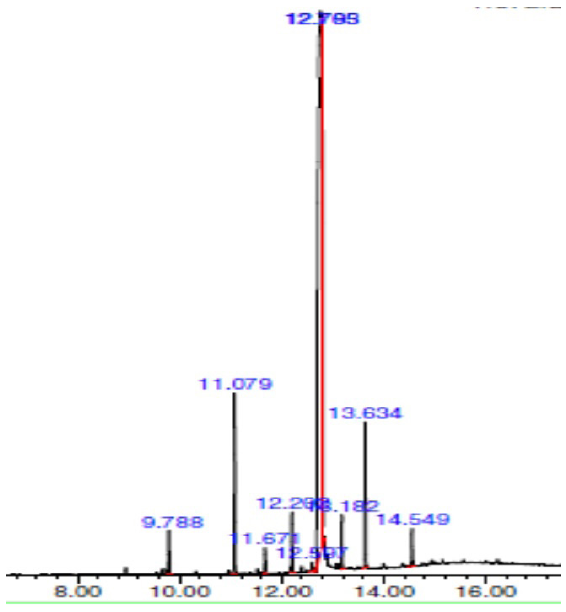
Figure 6: GC-MS chromatogram of FAMEs produced from ex-situ transesterification of Chlorella vulgaris . FAME products represented on retention time of 9.788; 11.082; 11.671; 12.204; 12.596; 12.791; 13.183; 13.634 and 14.548 min.